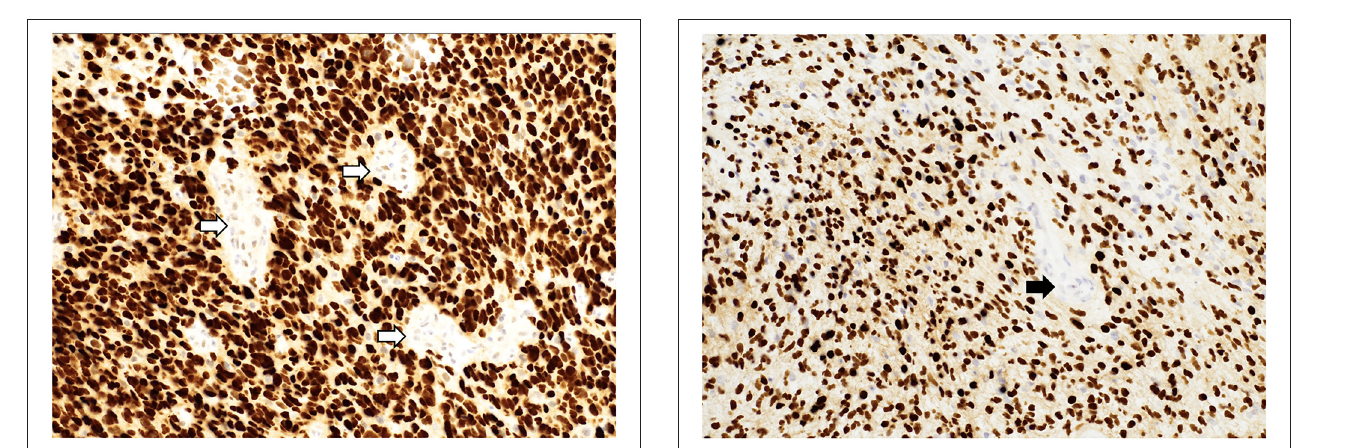
FIGURE 4 | A “glioblastoma” with a mutation in TP53 demonstrating strong, diffuse nuclear staining for p53 with wildtype staining present in vessels (arrows). p53 immunostain, 200x magnification.